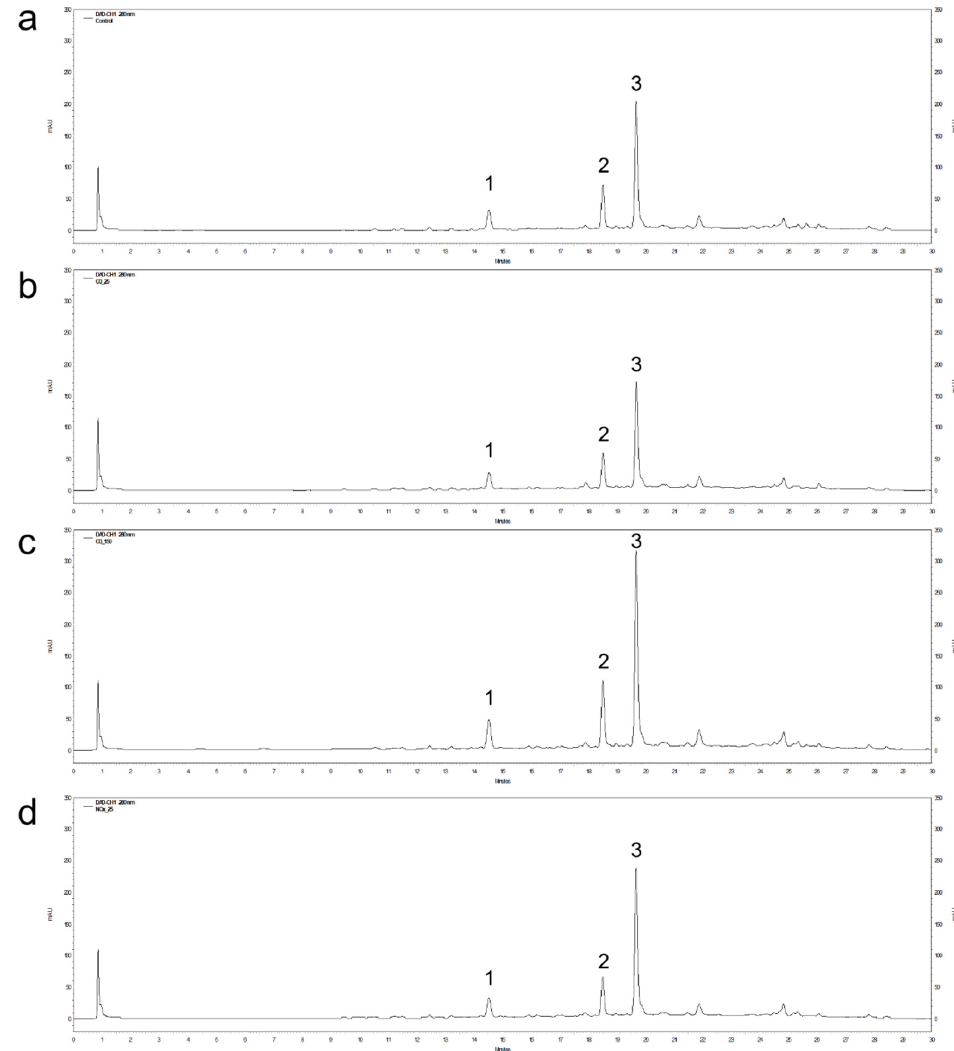
Figure 3. HPLC chromatograms of flavonoids from non-treated peanut shell extract ( a ) and extracts obtained by atmospheric-pressure plasma for the O 3 25 °C ( b ), O 3 150 °C ( c ), and NO x 150 °C ( d ) treatments. Peak numbers 1–3 refer to 5,7-dihydroxychromone, eriodictyol, and luteolin, respectively. Table 1. Content of 5,7-dihydroxychromone, eriodictyol, and luteolin (mg/g extract) in atmos-